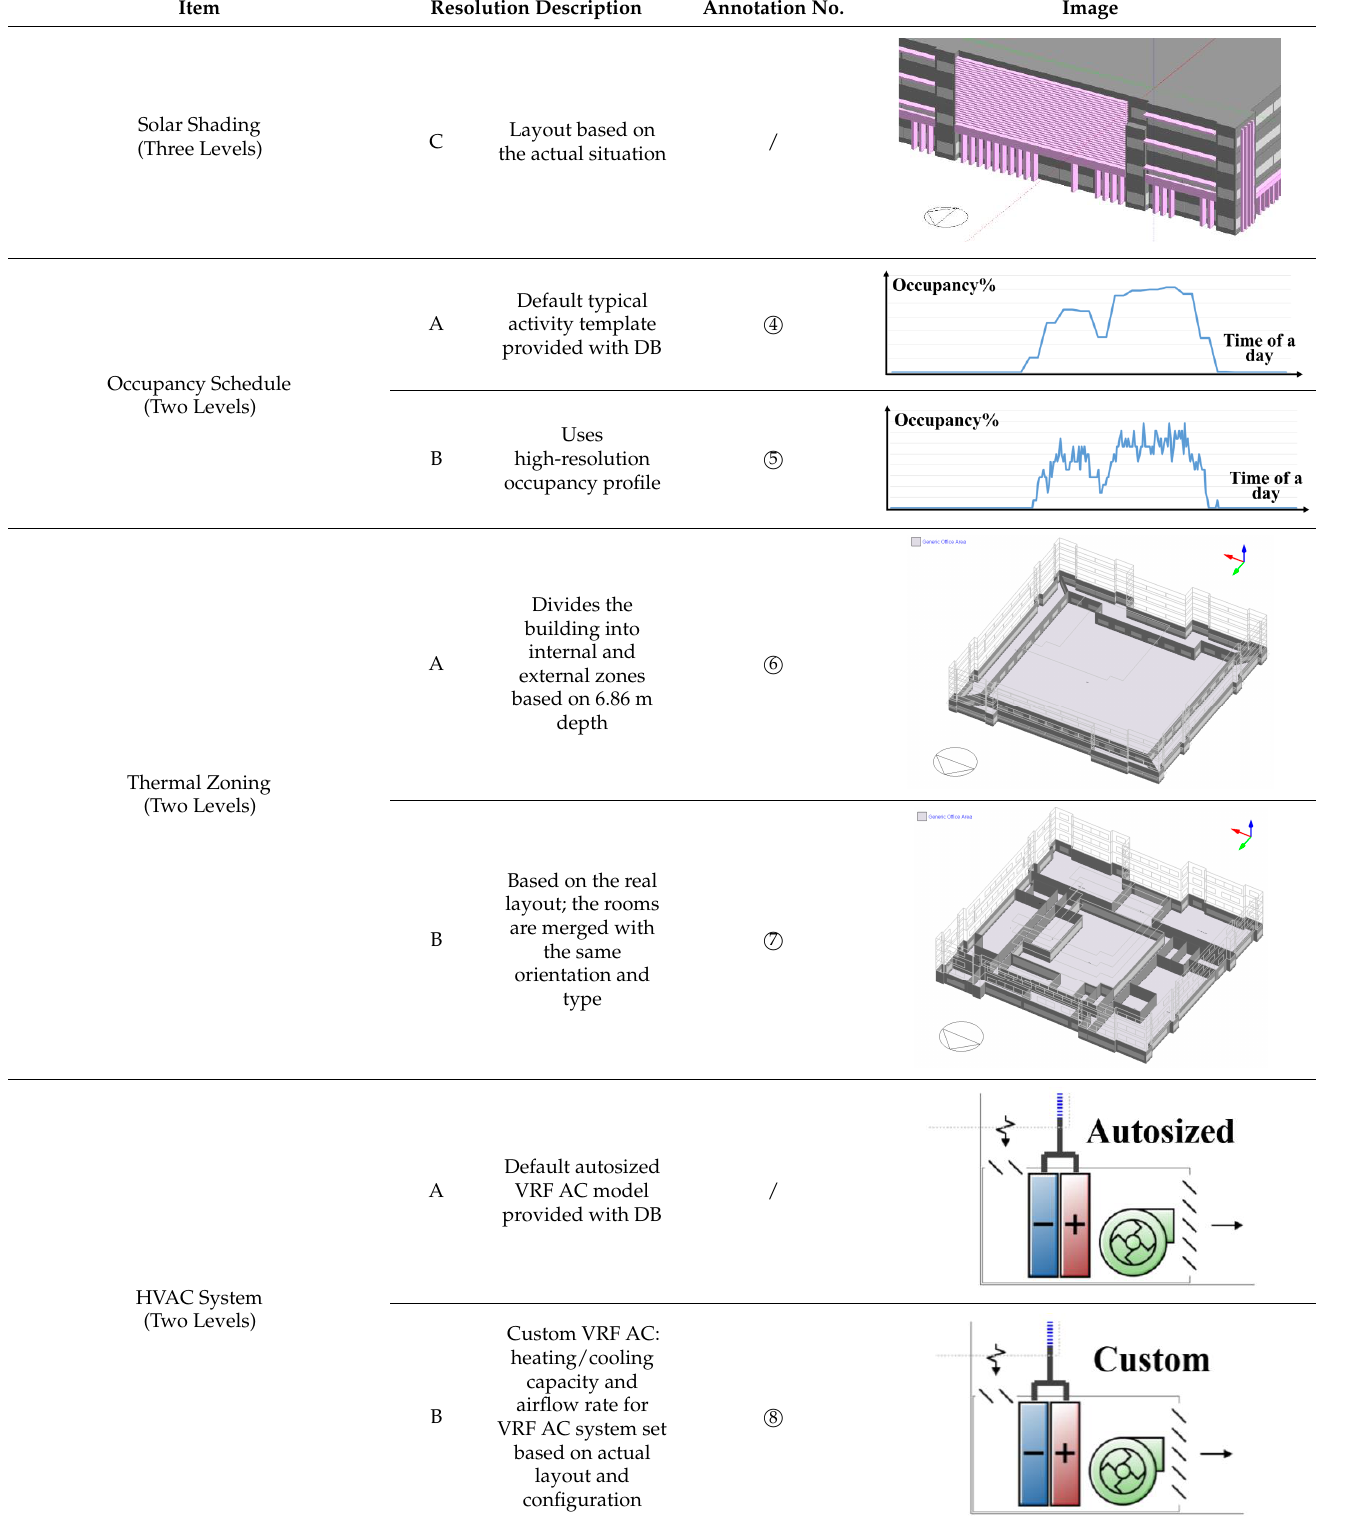
Table 3. Annotation of the energy-model resolution division.